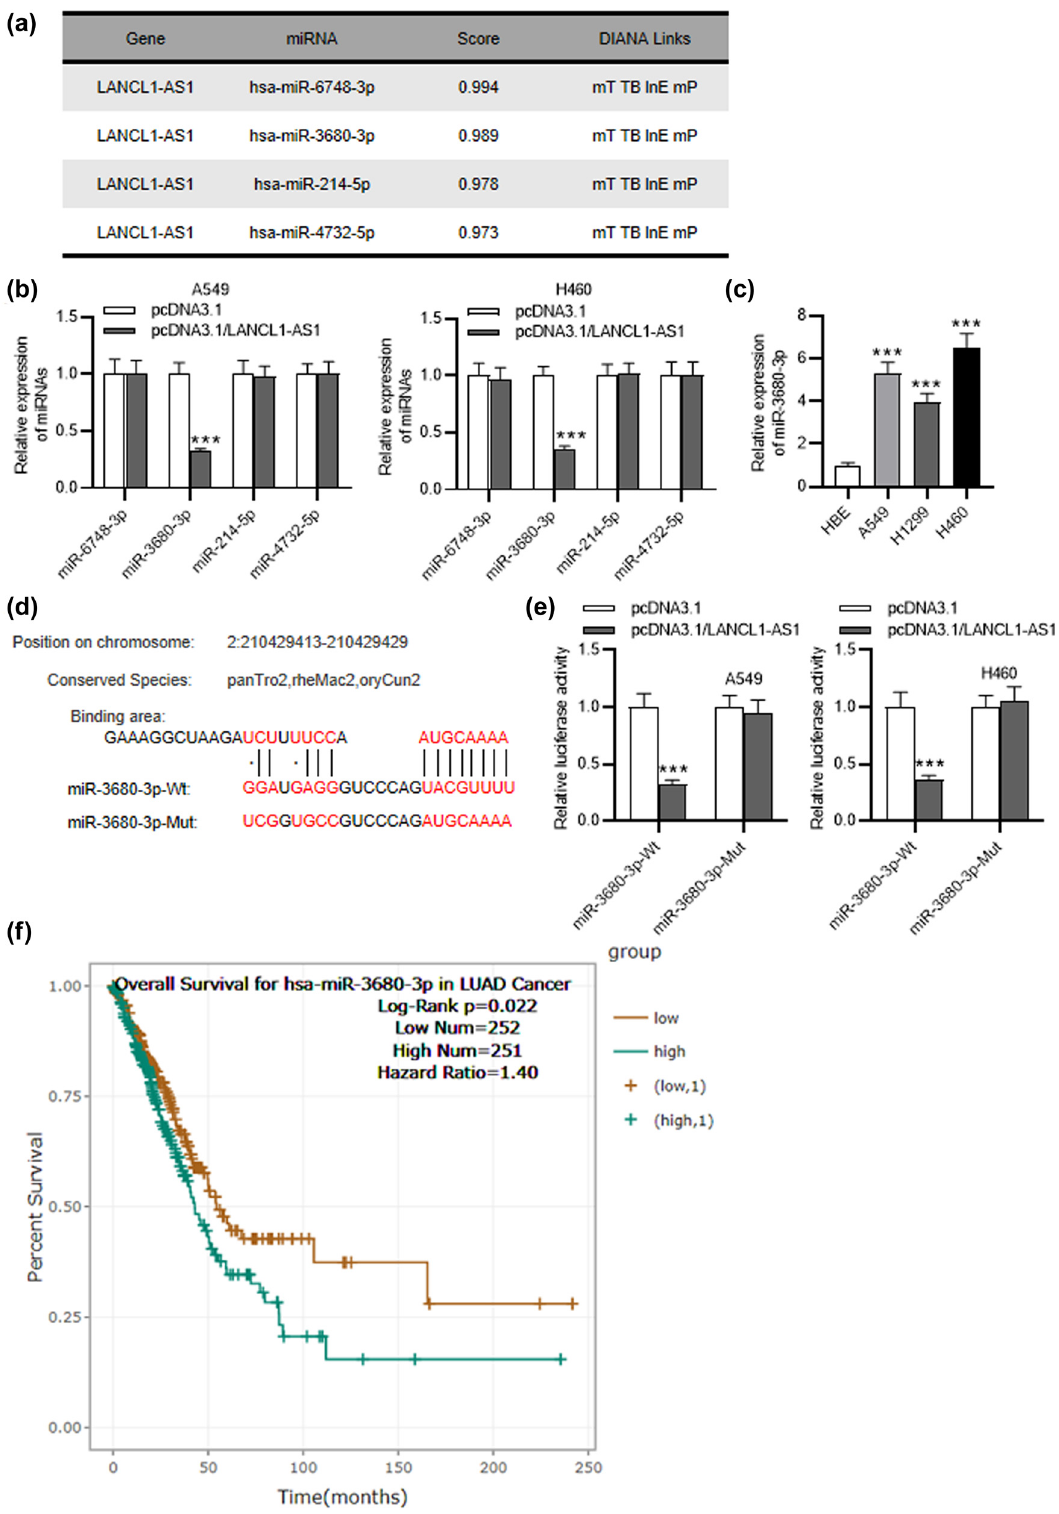
Figure 3: LANCL1 - AS1 binds to miR - 3680 - 3p. ( a ) LANCL1 - AS1 downstream miRNAs predicted by DIANA. ( b ) RT - qPCR analysis of the miRNA levels in LANCL1 - AS1 - upregulated A549 and H460 cells. ( c ) RT - qPCR of miR - 3680 - 3p level in NSCLC and normal cell lines. ( d ) Putative binding site between LANCL1 - AS1 and miR - 3680 - 3p shown by DIANA. ( e ) The relation between LANCL1 - AS1 and miR - 3680 - 3p veri fi ed by luciferase reporter assay. ( f ) The association between miR - 3680 - 3p expression and LUAD patient prognoses shown by ENCORI. *** p <